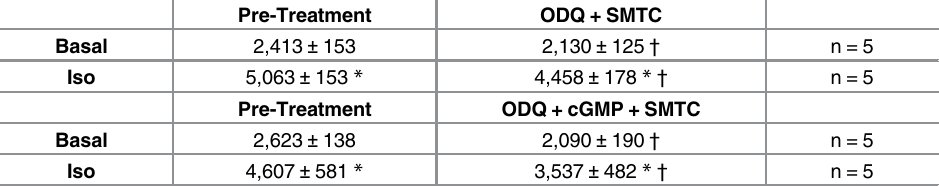
Table 2. NOS-1 inhibition reduces cardiac contractility independently of guanylate cyclase activity.